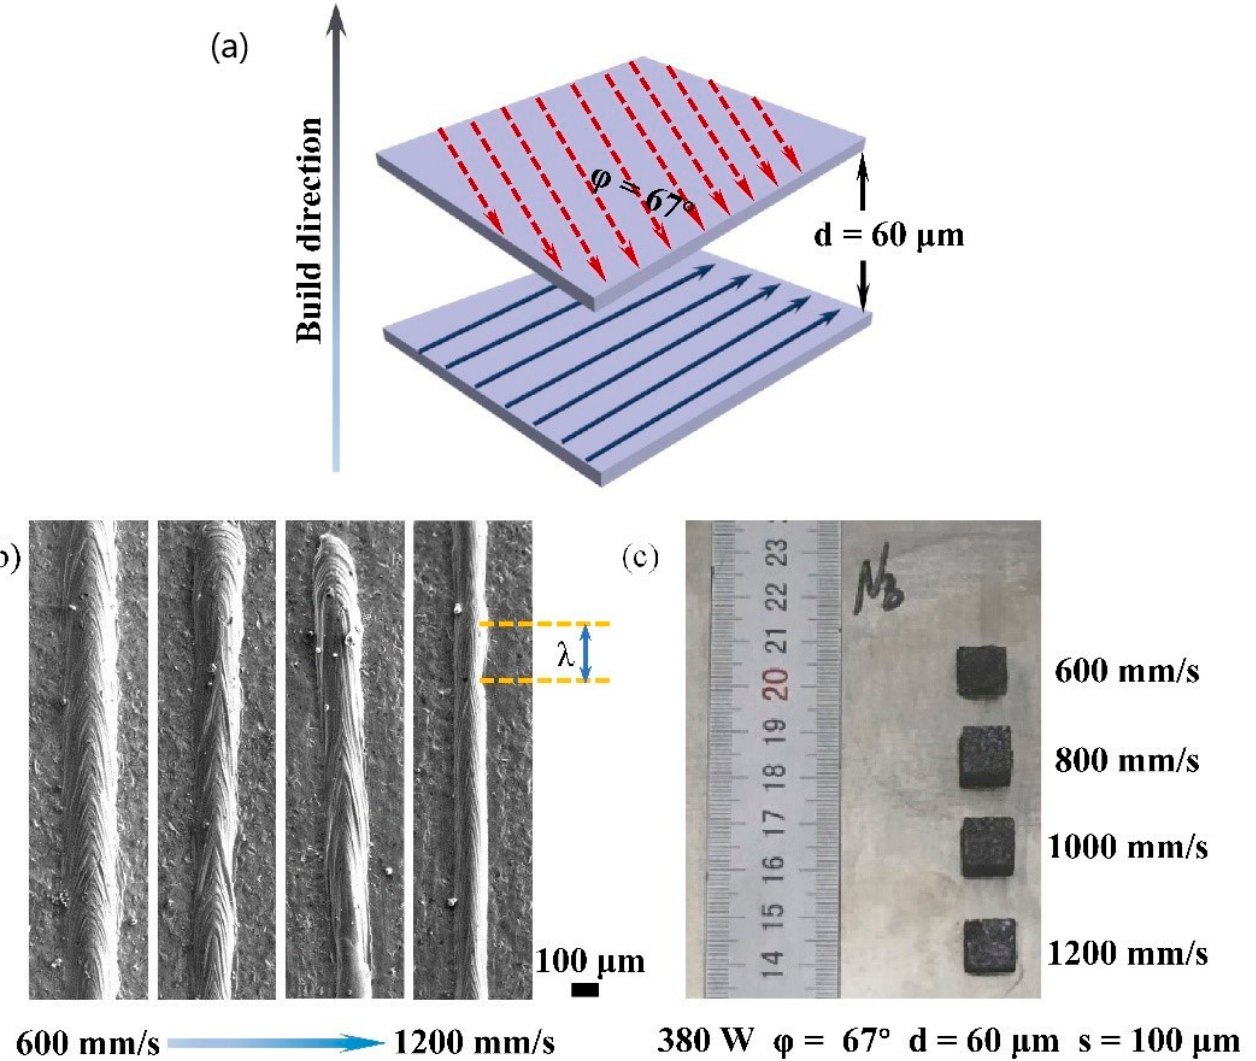
Figure 1. ( a ) Schematic illustration of meandering scanning strategy; ( b ) single-pass melt pool morphology at different scanning speeds; ( c ) schematic illustration of the as-printed 1 cm 3 cubic Nb-18Si-5HfC alloys cubic specimen on the titanium plate.